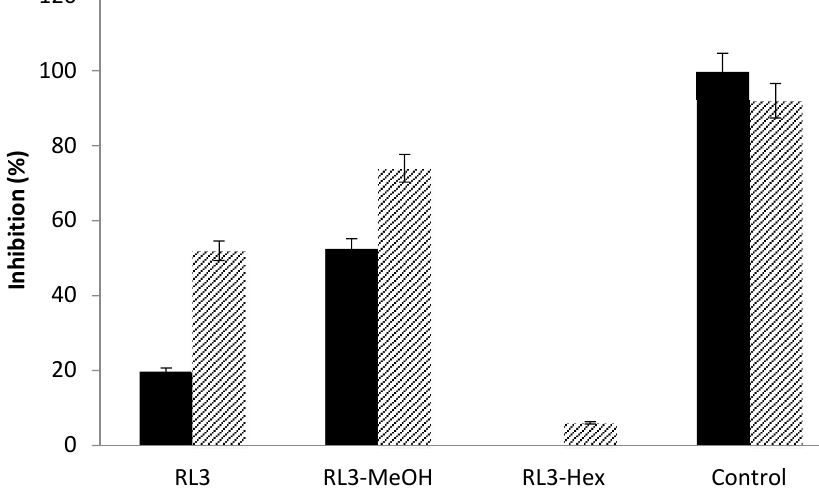
Figure 2. Tyrosinase (plain black) and lipoxygenase (hatched) inhibition of R. luteola sub-extracts RL3-Methanol and RL3-Hexane in comparison with those of the RL3 crude extract and control (kojic acid and quercetin were used as control for whitening and anti-inflammatory assays, respectively).